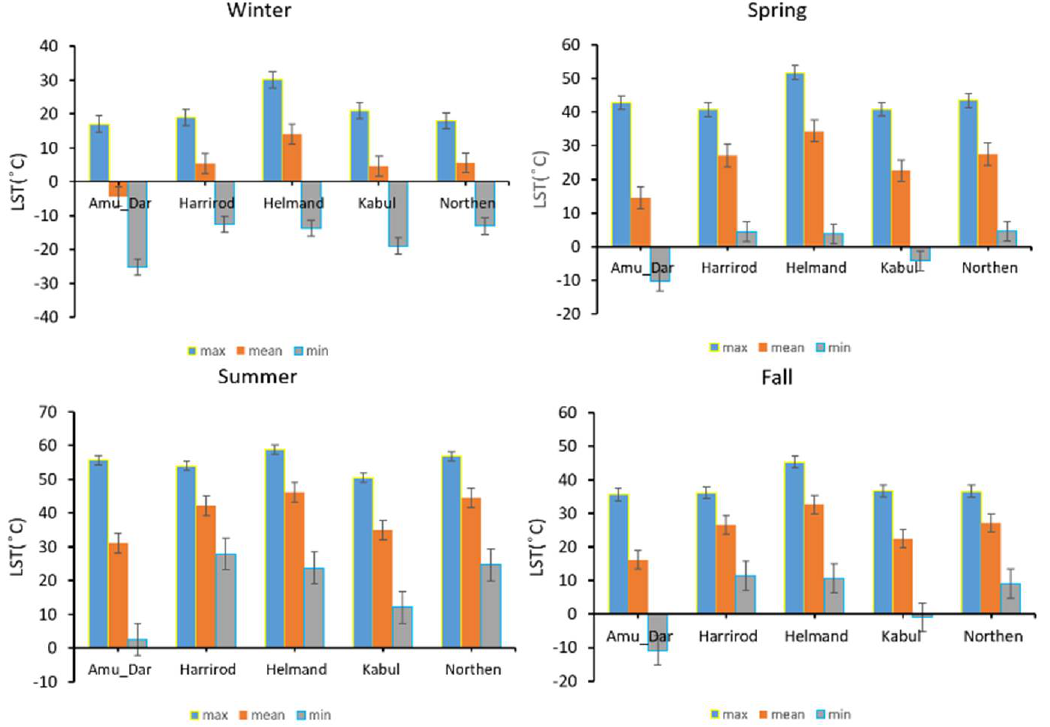
Figure 7. The maximum, minimum, and mean seasonal LST of Afghanistan’s basins in the period 2000–2021.